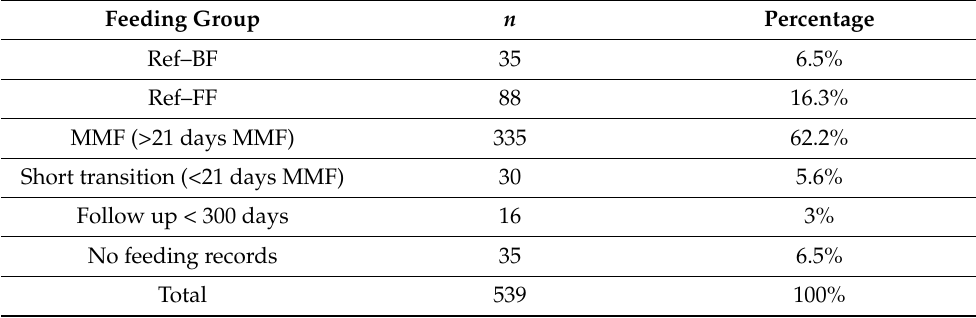
Table 2. Group sizes in Venus, including the percentage out of all of the subjects enrolled. Feeding